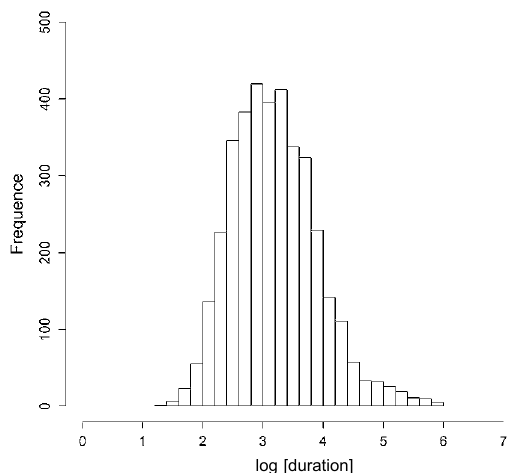
log Fig. 2. Distribution of traffic incident duration after log transformation